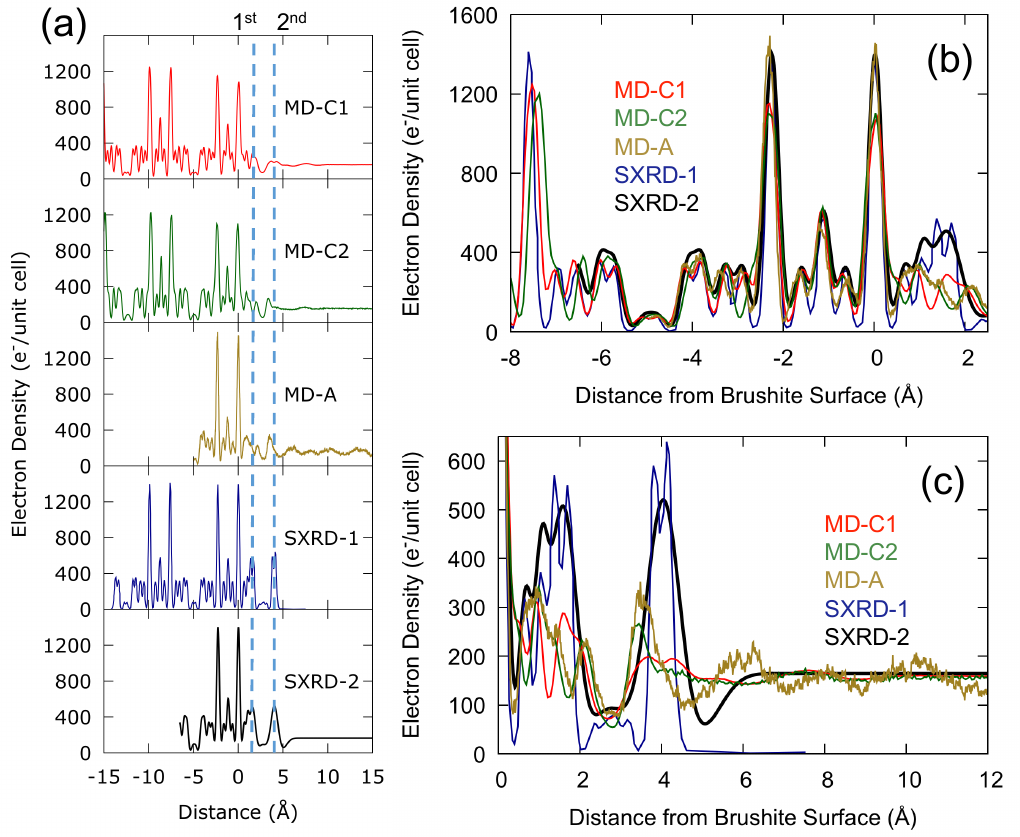
Figure 2. ( a ) Time averaged electron density profiles obtained by MD simulations (MD-C1 refers to simulations using the Demichelis et al. force field [24]; MD-C2 refers to the modified version of MD-C1; MD-A refers to the results from ab initio molecular dynamics) compared with the electron density profiles obtained via SXRD ( SXRD-1 refers to the published data of Arsic et al. and SXRD-2 refers to the same data with a fit including bulk water). Peak positions are listed explicitly in Table S2. The origin is chosen such that the top layer Ca is at z = 0 Å and densities are scaled to the experimental unit cell (lattice parameters a = 5.812 Å, b = 15.18 Å, c = 6.239 Å, and β = 114.13 ◦ ) [16]. Dashed blue lines indicate the 1st and 2nd hydration layer positions as indicated by SXRD. Overlaid density profiles for specific regions are also shown in the case of ( b ) the top two brushite layers and ( c ) the brushite–water